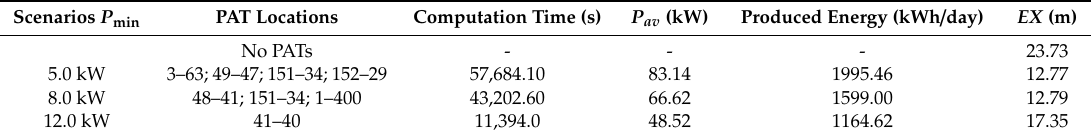
Table 5. Optimal PAT Locations, Energy Recovery and Average Excessive